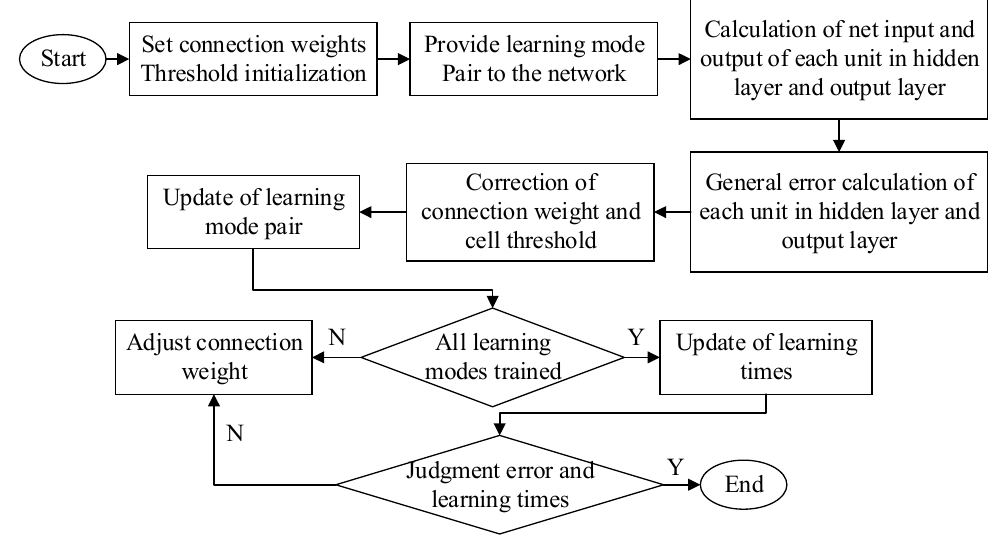
Figure 2. Implementation process of back propagation neural network (BPNN) .